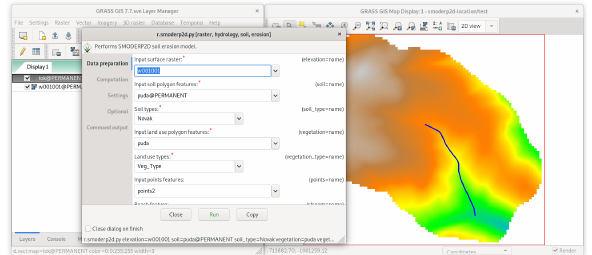
Figure 4. Running r.smoderp2d module from GRASS GIS graphical user interface